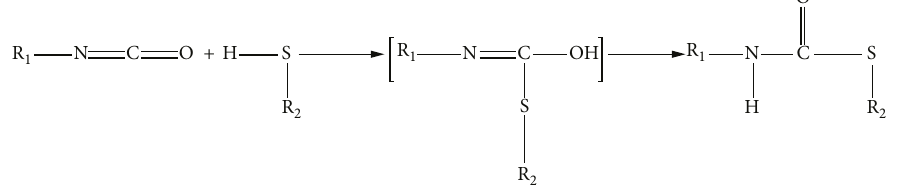
Figure 2: A diagram of polythiourethane formation.